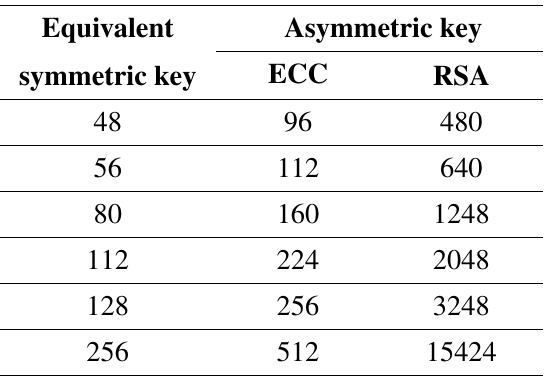
Table 5. Security level of cryptographic algorithms.